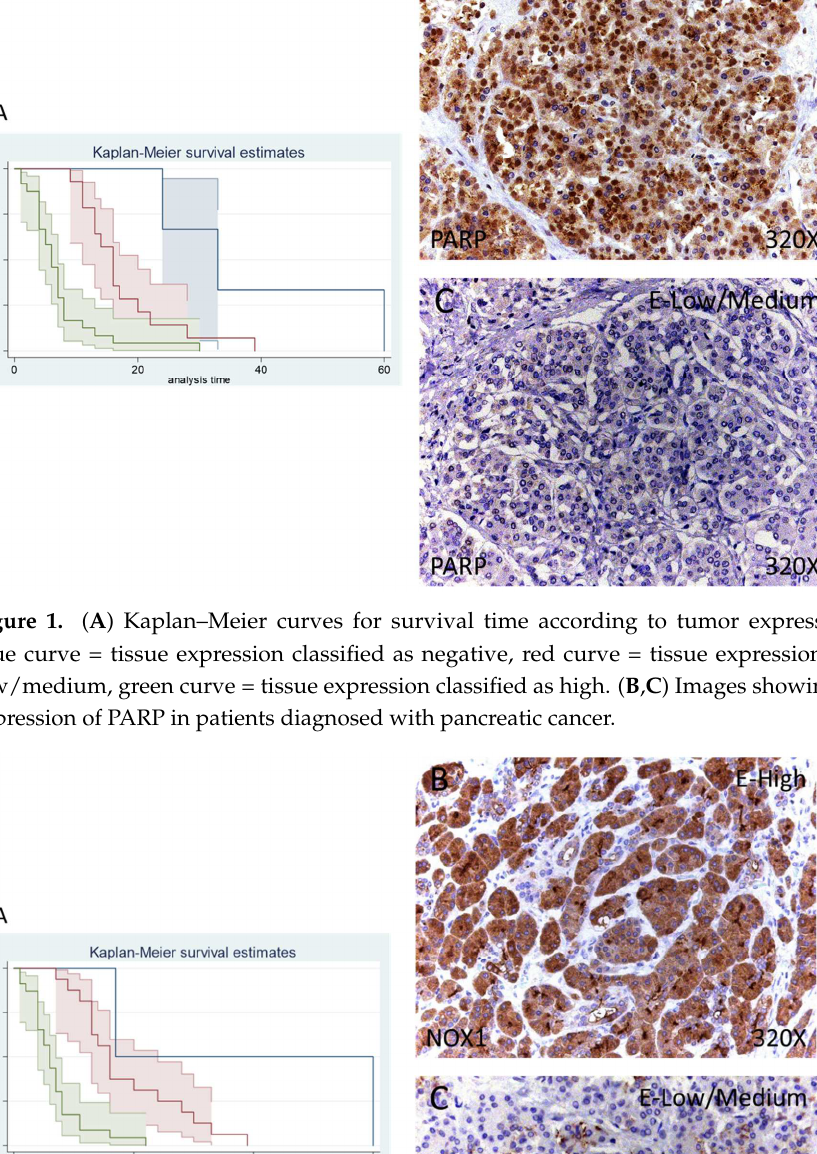
ate expression. The global comparisons displayed how the significance value was p < 0.001